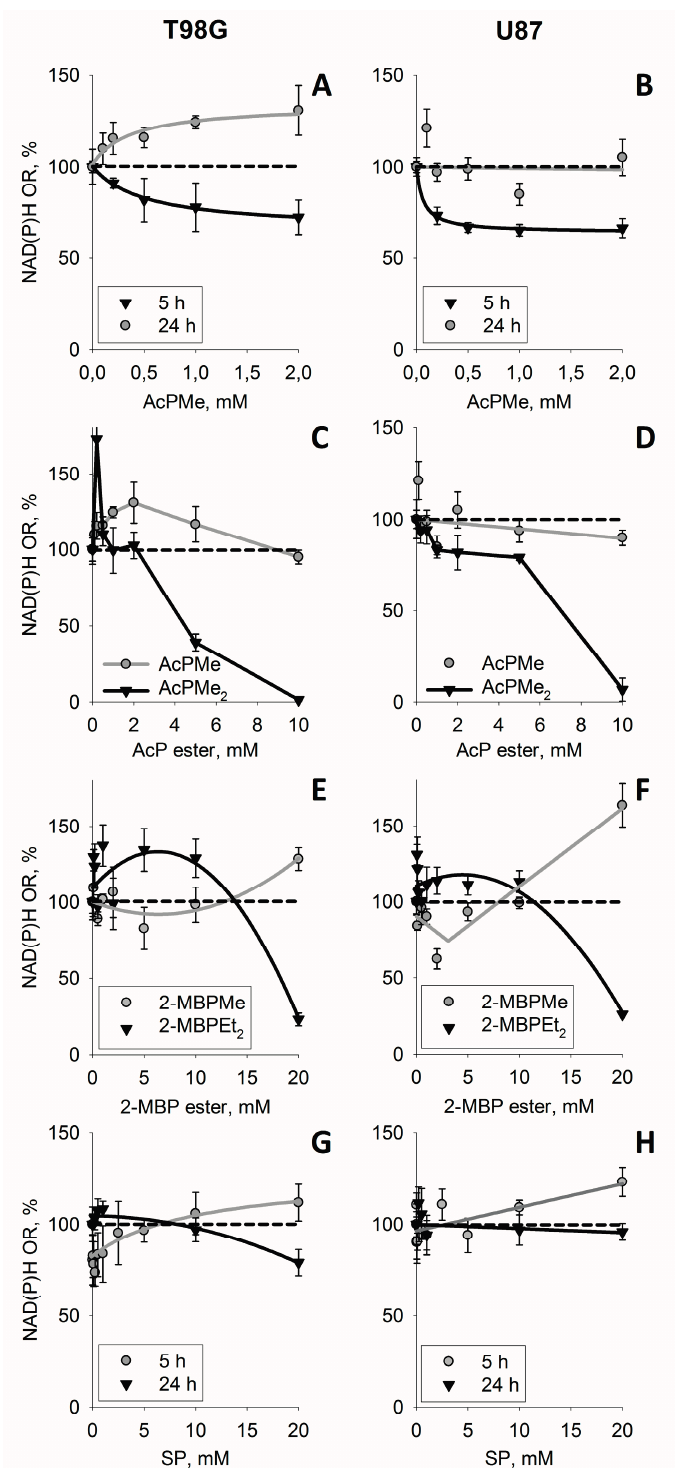
Figure 5. The time- and concentration-dependent changes in the NAD(P)H:resazurin oxidoreductase (NAD(P)H OR) of T98G (left panel) and U87 (right panel) cells due to the phosphonate analogs of pyruvate ( A – D ), branched-chain 2-oxo acids ( E , F ) and oxoglutarate ( G , H ). The phosphonate analogs were incubated with cells in HBSS ( A – D) or DMEM ( E – H ). Different incubation times ( A , B , G , H ) or analogs ( C – F ) are indicated in the legends on the graphs. When not indicated ( C – H ), the incubation time was 24 h. Structures and abbreviations of the phosphonate analogs used are given in Figure